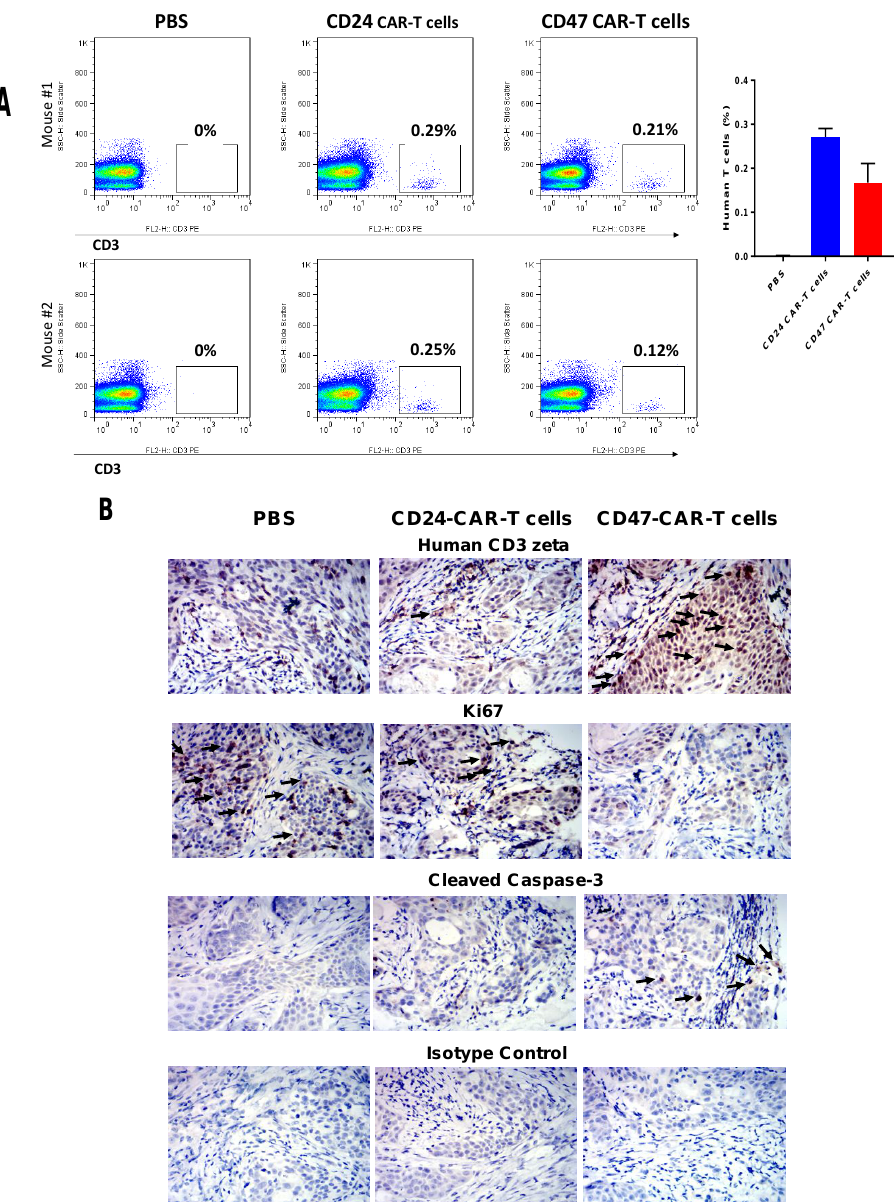
Figure 4. FACS staining of mouse blood cells and IHC of tumor samples detects presence of human T cells in blood and increase in tumors, decreased level of Ki67 and increased level of caspase-3. ( A ) FACS staining of mouse blood cells demonstrates significantly increased level of human T cells in CD47-CAR-T and CD24-CAR-T cells groups among all T cells. * p < 0.03; ( B ) IHC staining with CD3 zeta antibody demonstrates increased staining in CD47-CAR-T samples versus control 1xPBS and CD24-CAR-T cells (upper panels); IHC staining with Ki67 antibody demonstrates decreased Ki67 level in CD47-CAR-T samples versus control 1xPBS and CD24-CAR-T cells samples. IHC with caspase-3 antibody demonstrates increased level of cleaved caspase-3 in CD47-CAR-T cells treated tumors versus control tumor samples; The IHC staining with isotype control IgG1 antibody was negative in three groups (lower panels). Black arrows show differences in IHC staining.